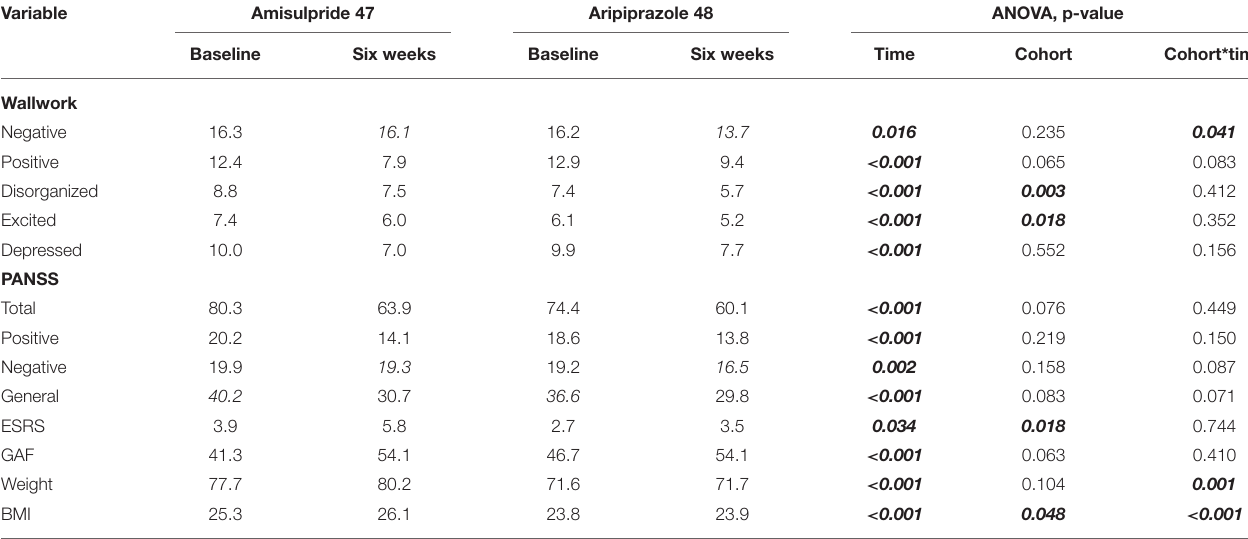
TABLE 2 | Psychopathology, side effects and level of function for both cohorts at baseline and after six weeks.